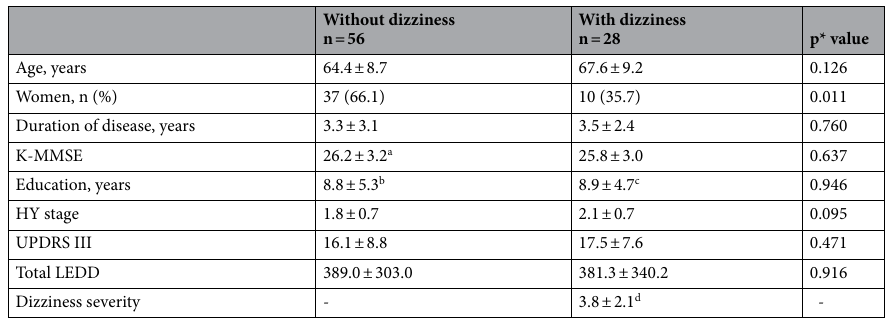
Table 1. Clinical characteristics of patients without dizziness and with dizziness. K-MMSE, the Korean version of the Mini-Mental State Examination; HY stage, Hoehn and Yahr stage; UPDRS III, Unified Parkinson’s Disease Rating Scale part III; Total LEDD, total levodopa equivalent daily dose. Values are expressed as means ± SD or number (percentage). Dizziness severity was evaluated with visual analogue scale having a range of scores from 0 to 10. Missing cases were not included and the number of the case was a two, b four, c one, and d three. *p < 0.05 indicates significant differences.